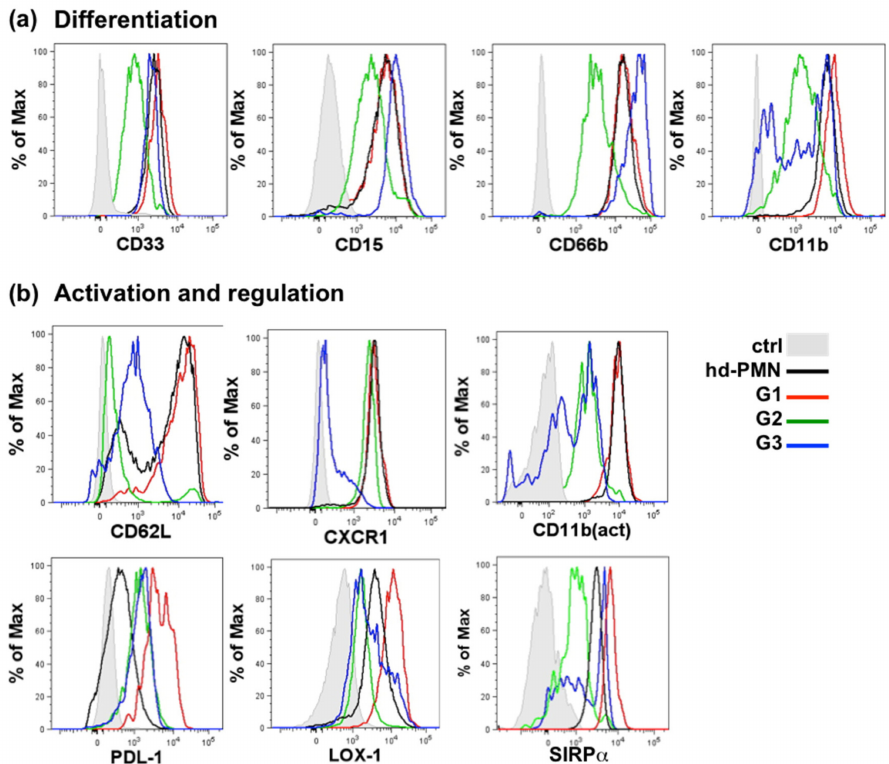
Figure 5. Phenotypic characterization of the G1, G2 and G3 subsets of PMN-MDSCs. Expression of markers sequentially expressed during granulocytic differentiation ( a ) and of markers of activation or regulation ( b ). Histograms show overlays of G1, G2, G3, high-density PMNs and control. An example of a typical expression profile was selected from 5 to 15 patient sample. For ( a ) control is unstained cells, for ( b ) control is matched